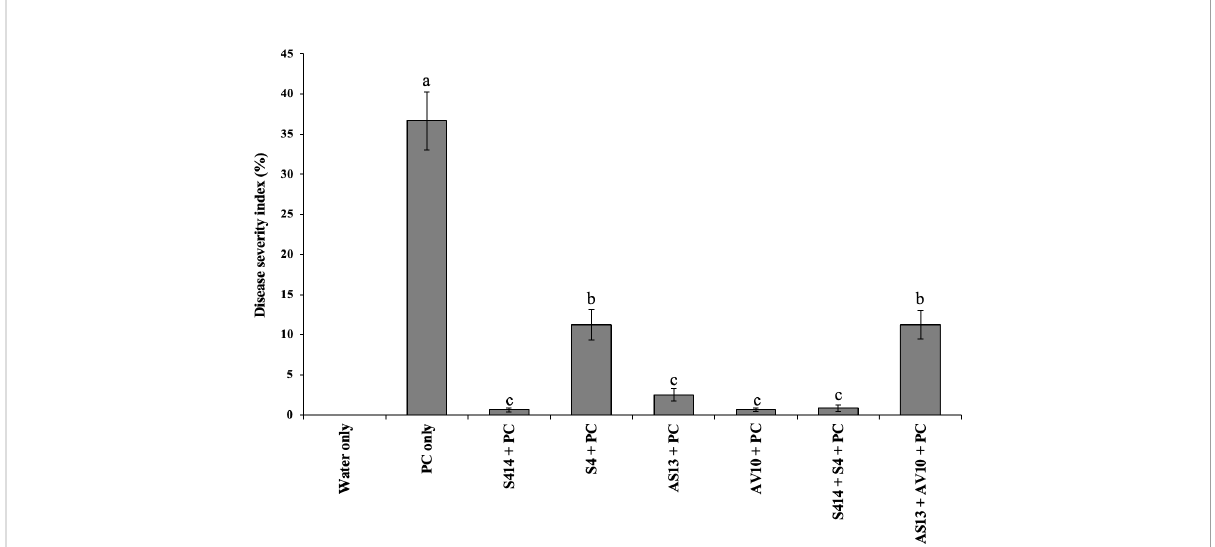
FIGURE 7 Biocontrol ef fi cacy of bacterial strains against P. colocasiae disease development on taro plants under greenhouse conditions. Data are the means ± standard deviation. Means with different letters indicate a signi fi cant difference between the treatments according to Duncan ’ s multiple ranges at P ≤ 0.05